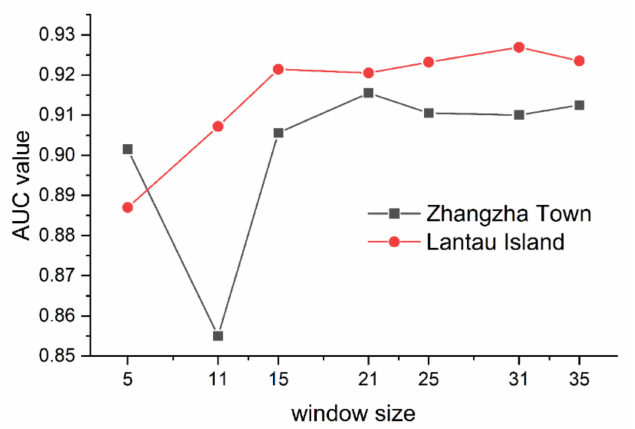
Figure A2. AUC variation of the CNN-based model with different window